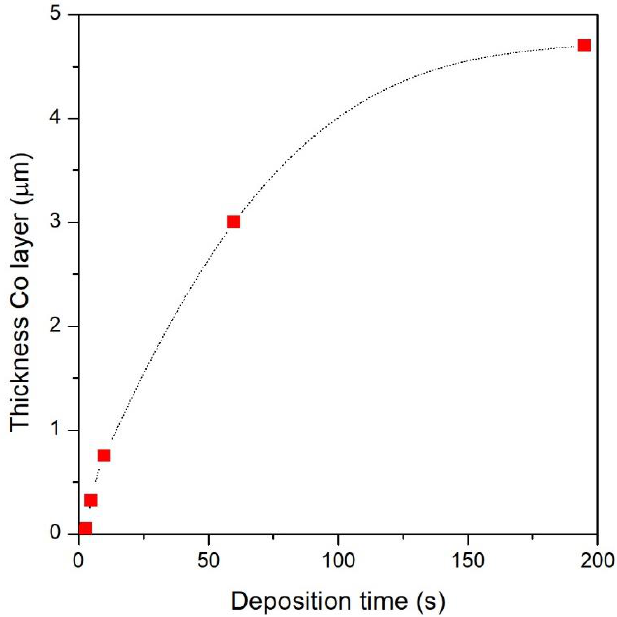
Figure 5. Evolution of the thickness of the Co layer as a function of deposition time.